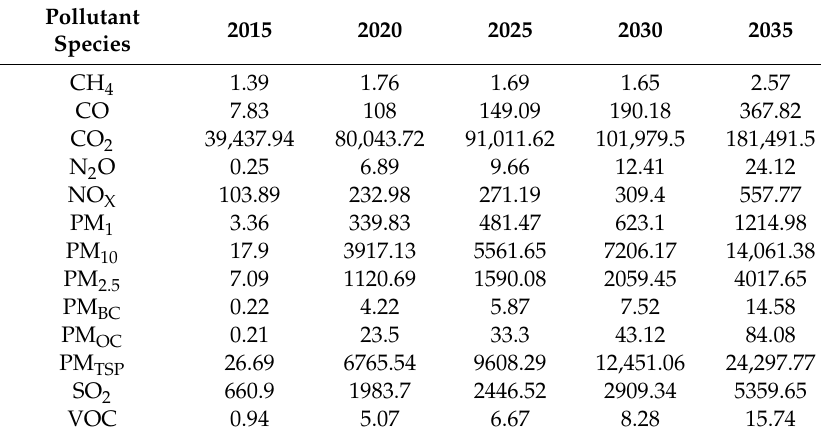
Table 2. Air pollutants emissions in BAU Scenario